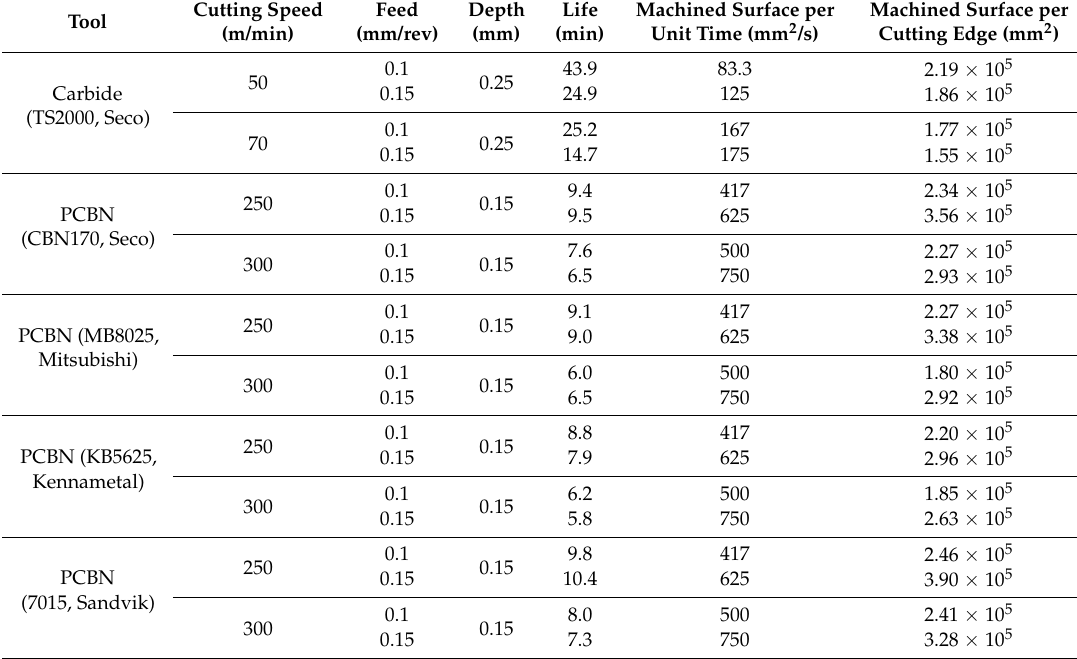
Table 4. Tool life and machined surface for PCBN and carbide tools.